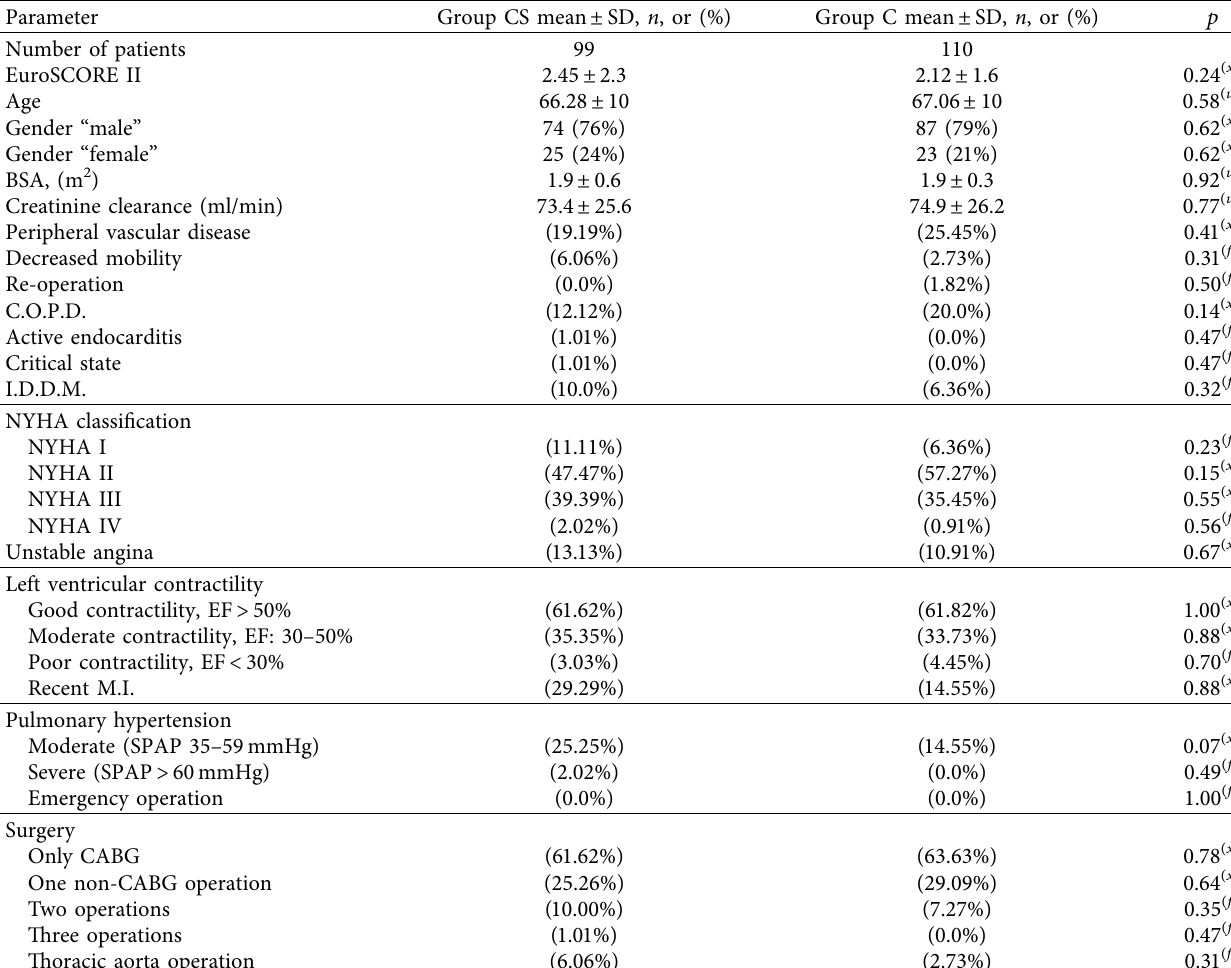
Table 1: Demographics and comorbidities ( ( x ) : χ 2 test, ( u ) : Mann–Whitney U -test, ( f ) : fisher’s exact